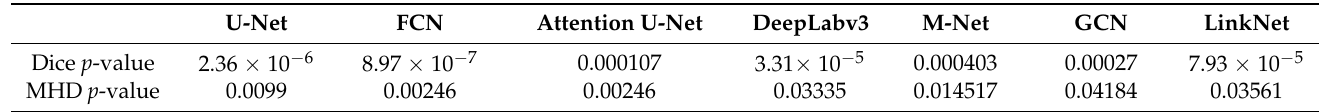
Table 3. Paired t -test with Bonferroni correction of Dice and MHD metrics between the proposed method and